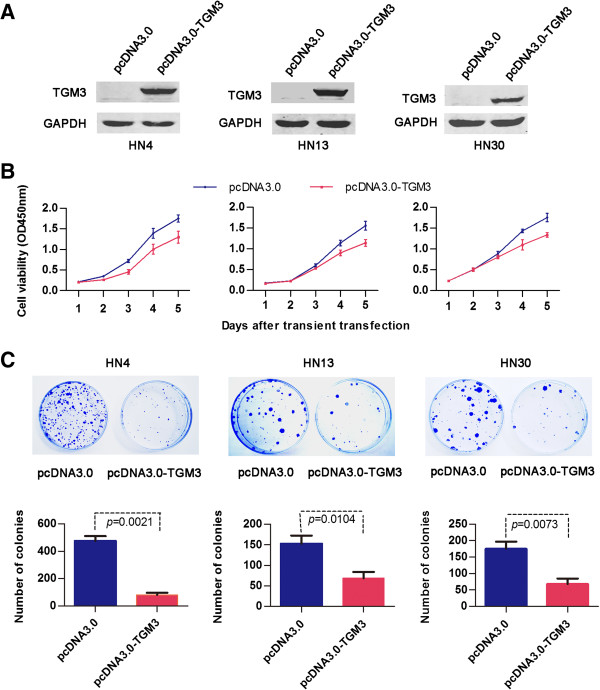
The effect of TGM3 on cell growth and colony formation of HNSCC cell lines. (A) Western blot analysis confirmed the exogenous expression of TGM3 in HN4, HN13 and HN30 cells. (B) The growth of HN4, HN13 and HN30 cells transfected with the pcDNA3.0 and pcDNA3.0-TGM3 vectors were analyzed using the CCK-8 kit; the symbols represent the mean values of triplicate tests (mean ± SD). (C) Representative dishes show the inhibitory effect of TGM3 on colony formation compared with the empty vector control. All experiments were repeated at least 3 times.